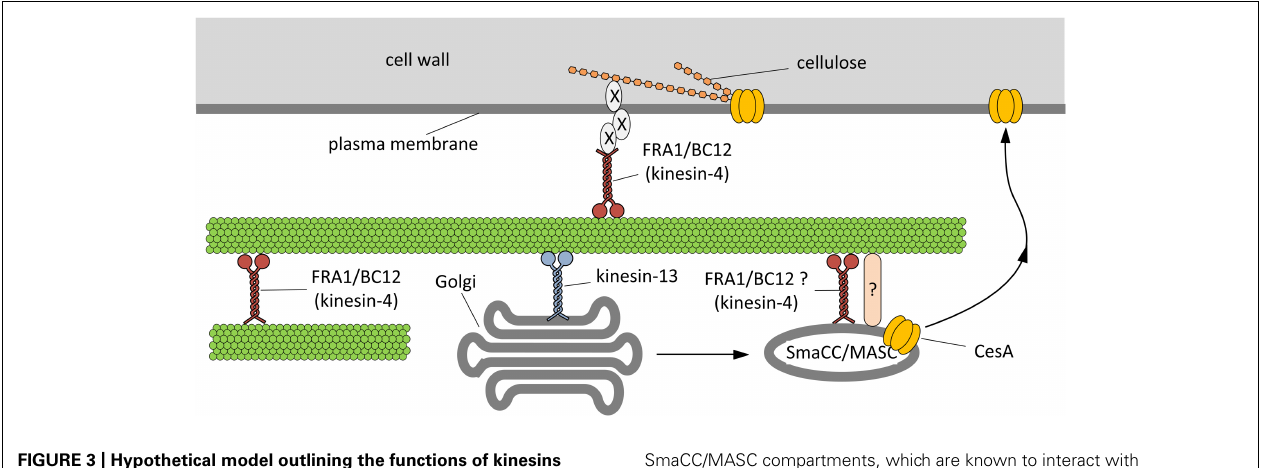
FIGURE 3 | Hypothetical model outlining the functions of kinesins during the assembly of cell wall. On the basis of current literature, members of the kinesin-4 subfamily (FRA1 and/or BC12) might be used to organize microtubules beneath the plasma membrane in order to favor either the proper insertion or the activation of cellulose synthase (CesA). The interplay between kinesins and CesA might be also more direct. Members of the kinesin-13 subfamily have been hypothesized either to transport locally or to pause Golgi stacks along microtubules. Once assembled in the Golgi stacks, CesA might move into the so-called